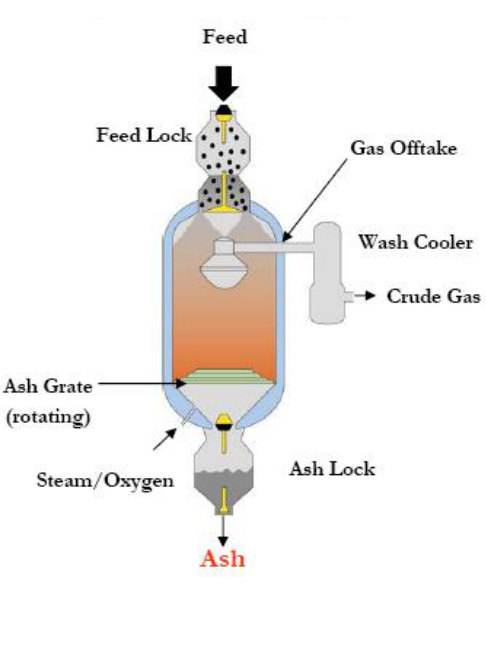
Figure 13. Lurgi Mark IV Gasifier [1].